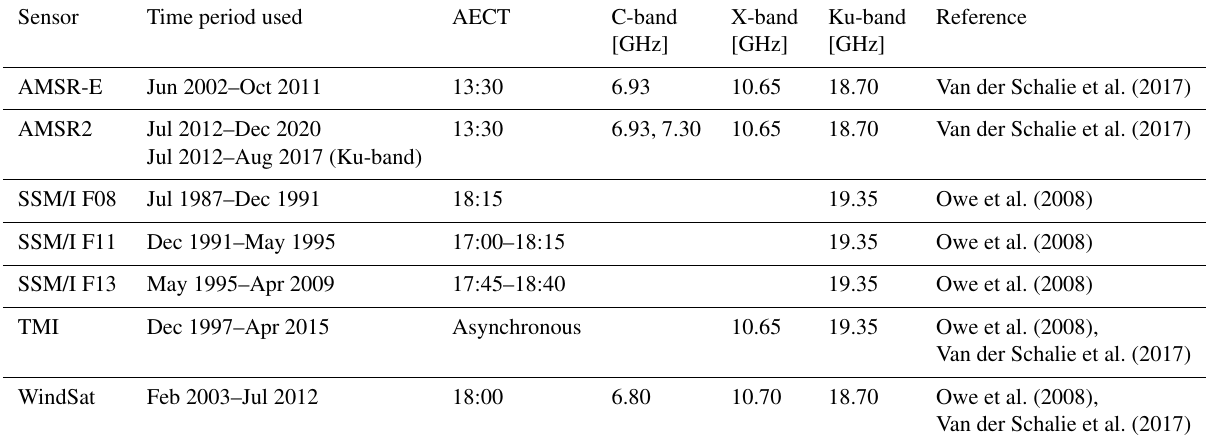
Table 1. Input data for the merged-band VODCA v2 with the main sensor specifications: time periods used, local ascending equatorial crossing times (AECTs), and frequencies used. Table information is taken from Moesinger et al. (2020) and adapted for VODCA v2 CXKu. Sensor Time period used AECT